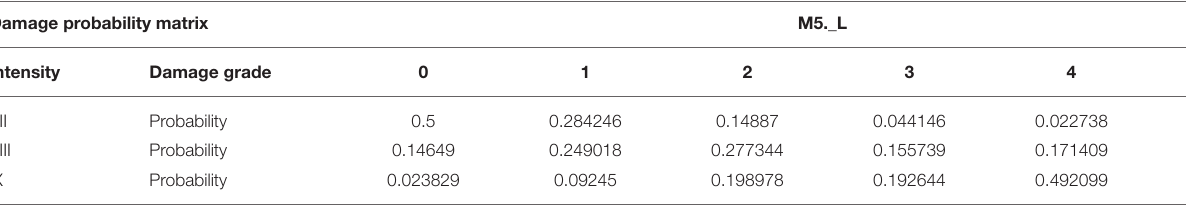
TABLE 4 | Damage probability matrix for M5.v_L. Damage probability matrix